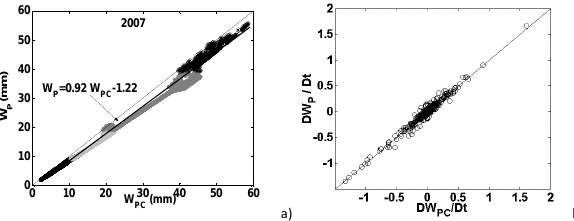
Fig. 9. Scatter plots of W P versus water vapour obtained using the Choudhury formulation, W PC (a) and their normalized time deriva- tives (b)